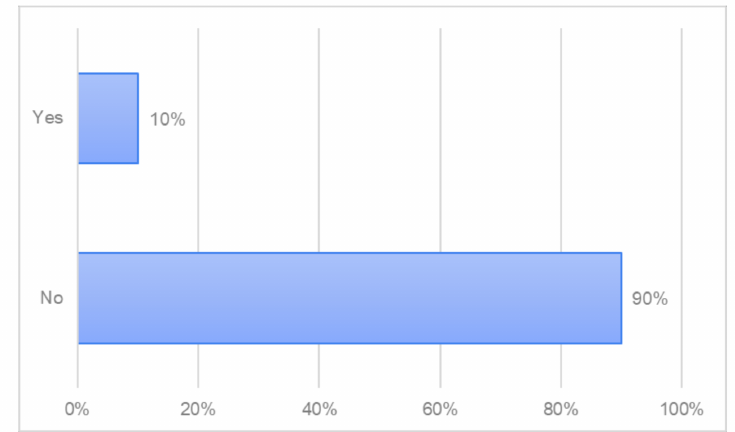
Figure 3. Rate of injuries caused by rope